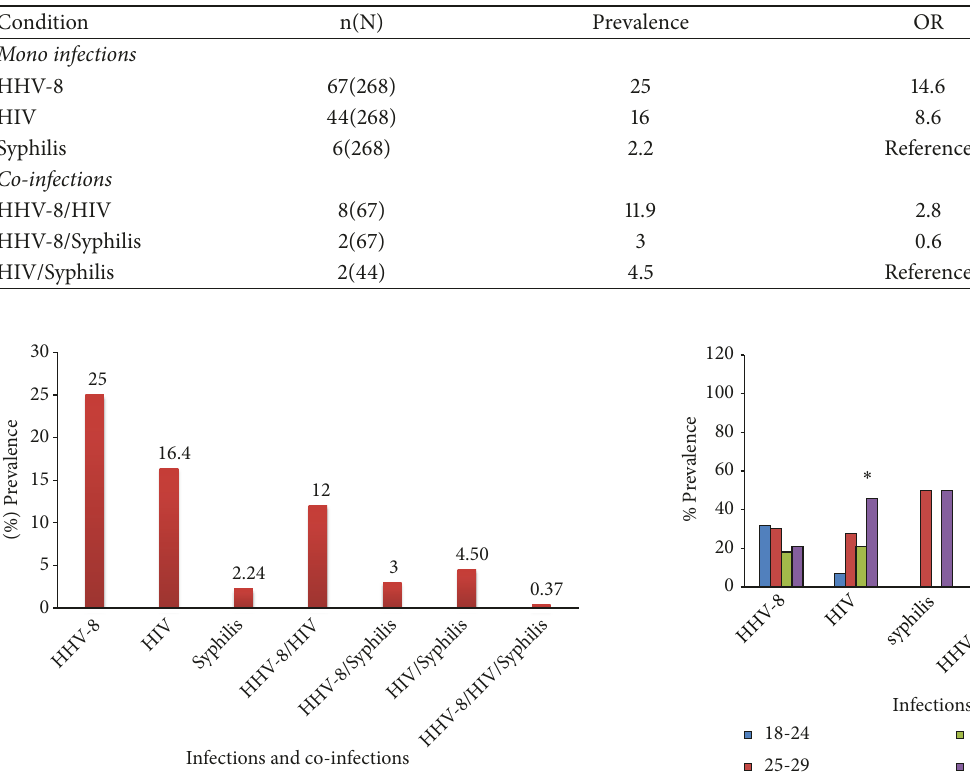
Table 2: Likelihood of infections.